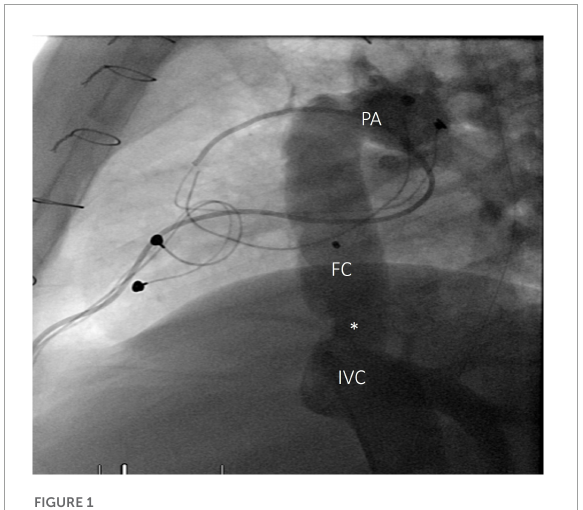
FIGURE1 Angiography of inferior vena cava, lateral view. Stenosis at the proximal anastomosis (white asterisk) of a Fontan conduit, 15 years after intervention. FC, Fontan conduit; IVC, inferior vena cava; PA, pulmonary arteries.